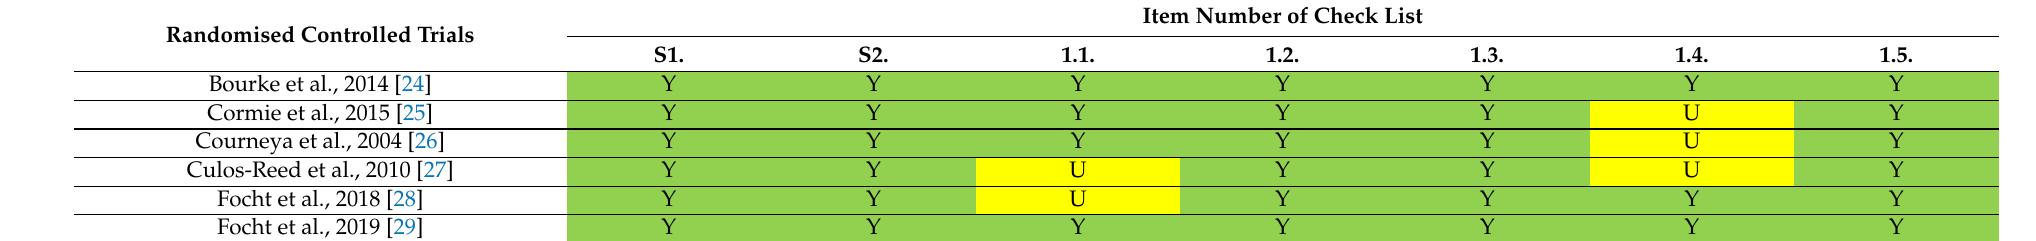
Table 3. Assessment of quality appraisal in the included